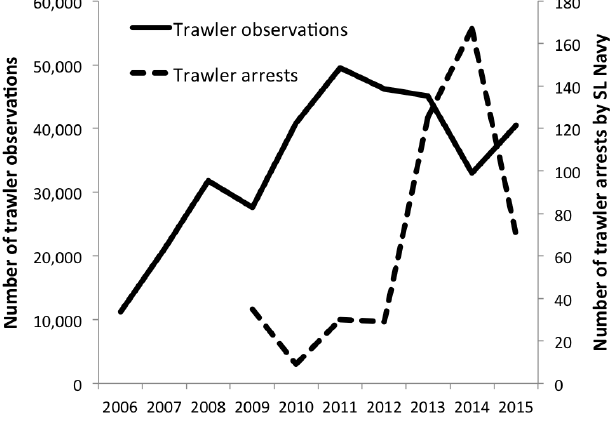
Fig. 1 . Annual observations and arrests of Tamil Nadu trawlers in Sri Lankan waters (Source: Sri Lankan Navy 2016, unpublished data